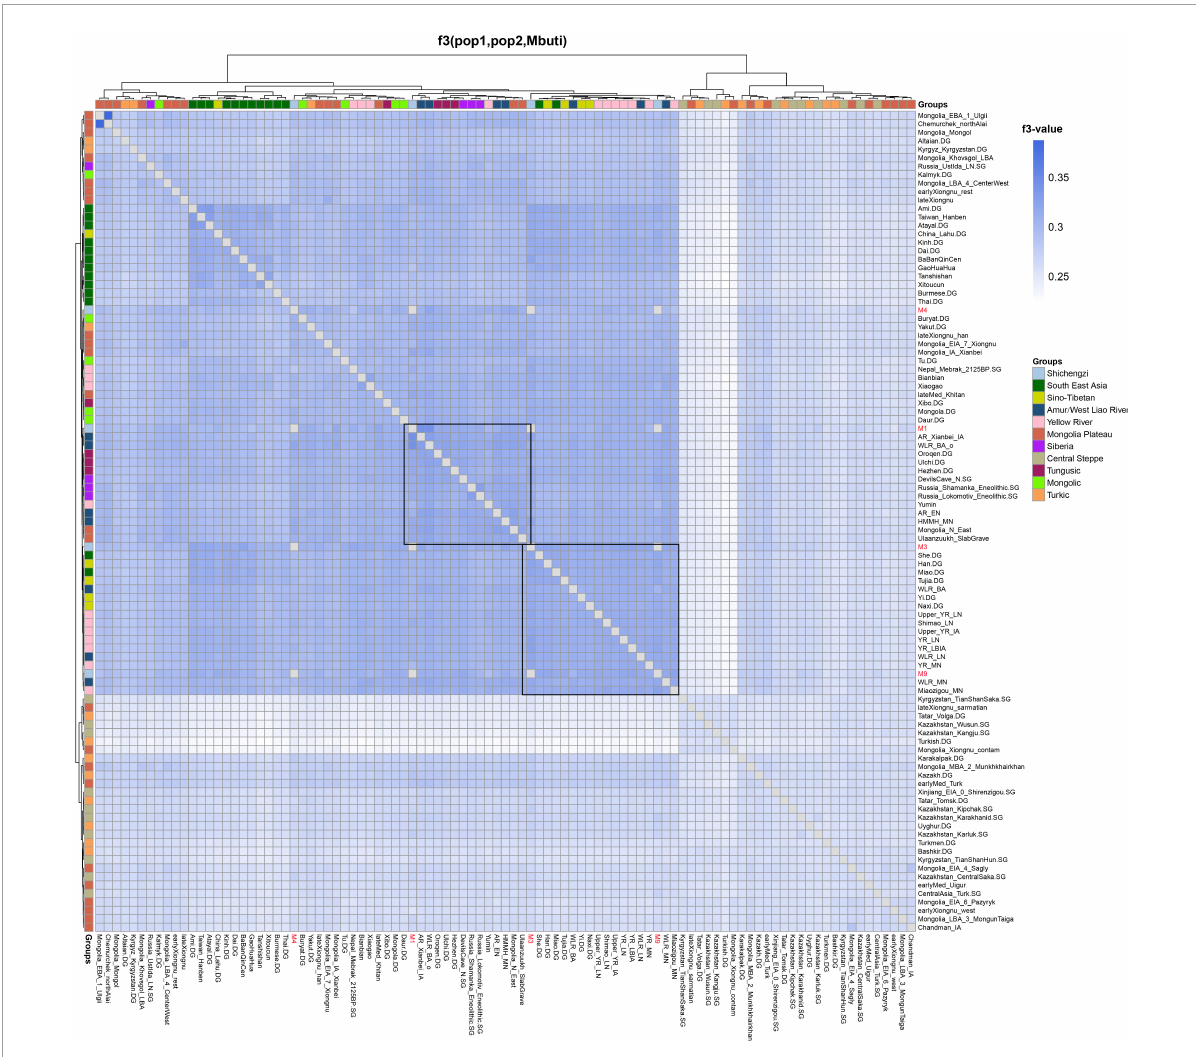
FIGURE5 The results of f 3 (X1, X2; Mbuti) based on the 1240k dataset show the genetic relationship among East Eurasians. Darker colors indicated a larger-f3 value and more shared alleles between a pair of tests.